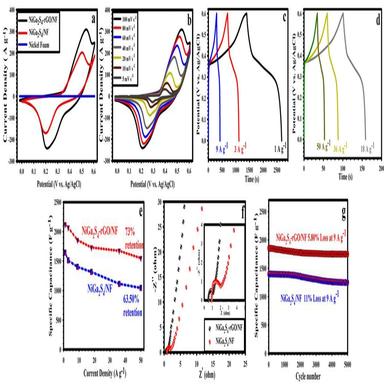
The electrodes' electrochemical performance in a three-electrode system. (a) CV curves of the Ni foam substrate, NiGa2S4/NF and NiGa2S4-rGO/NF at 100 mV s1 in 6 M KOH solution. (b) CV curves of the NiGa2S4-rGO/NF at different scan rates in 6 M KOH solution. (c and d) Galvanostatic charge/discharge curves of the NiGa2S4-rGO/NF at several current densities. (e) The rate capability of the NiGa2S4/NF and NiGa2S4-rGO/NF. (f) Nyquist plots of the NiGa2S4/NF and NiGa2S4-rGO/NF. (g) Cycling stability of the NiGa2S4